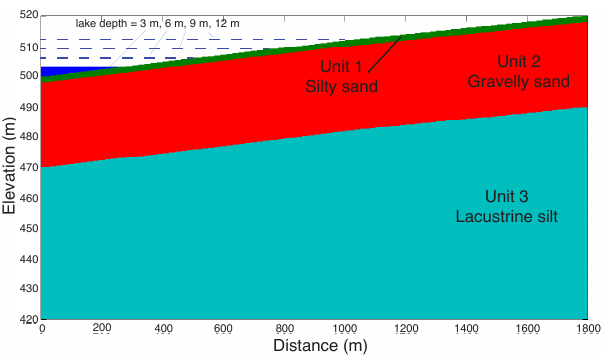
Figure 1. Axis-symmetric model geometry indicating different lithologic units and simulated lake depths/extents.